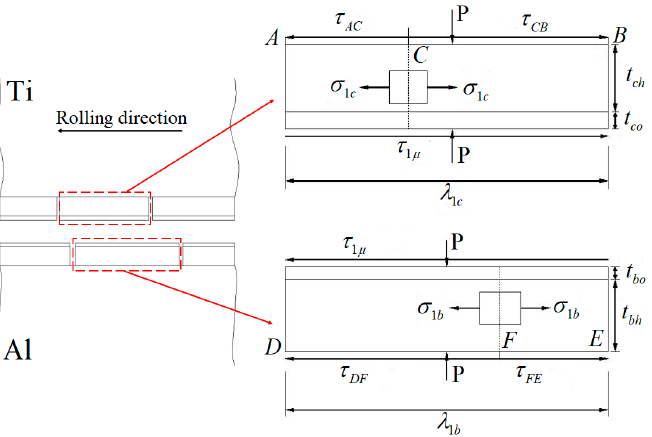
Figure 27. Model for the fracture of the hardening layer and oxide film at the roll bite due to extension of the substrate metal during cold rolling [12].